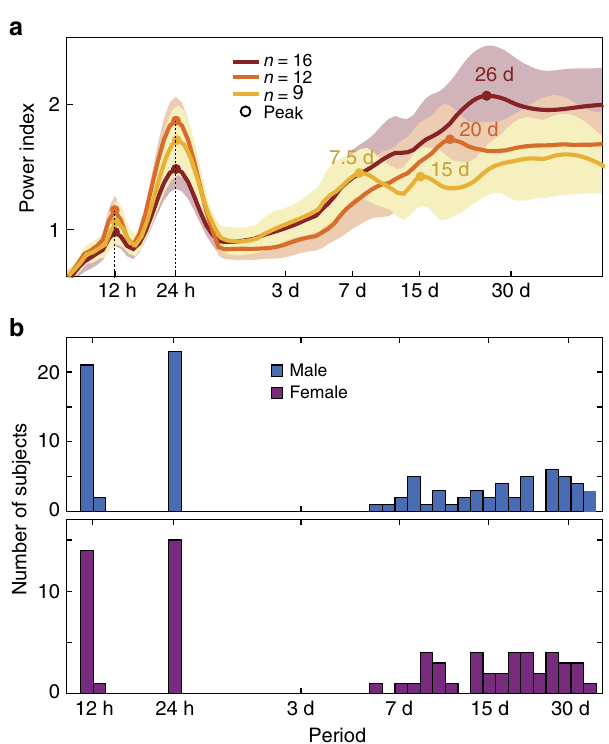
Fig. 2 Periodograms and peaks of IEA rhythms. a Average periodograms across all subjects ( N = 37) showing ultradian, circadian, and multidien peaks. For better visualization, unsupervised clustering across all subjects revealed three patterns: (i) about weekly-to-biweekly rhythm (peaks at 7.5 and 15 days, N = 9), (ii) about tri-weekly rhythm (peak at 20 days, N = 12), and (iii) about monthly rhythm (peak at 26 days, N = 16). Shading indicates ± 1 SD. b Histograms showing the number of subjects with a peak in the periodogram at a given period. The distributions are similar ( p = 0.87, χ 2 -test) in male ( N = 22) and female ( N = 15)